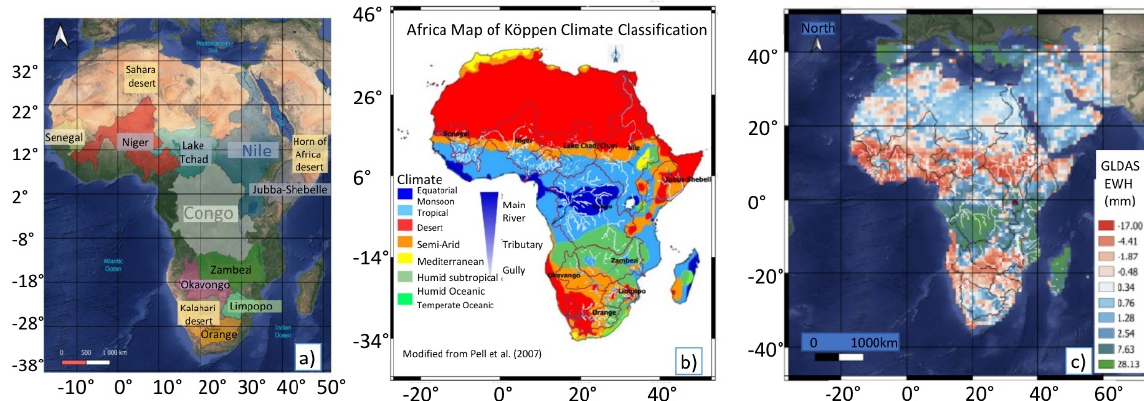
Figure 1. Hydrological and climate maps of Africa: ( a ) geographical masks of the main drainage basins. In this study, we analyzed two specific basins: Congo/Zaire (white color), and Nile (blue) but SF inversion have been made on the ten major basins, i.e., Niger (red, ~2.26), Zambezi (dark green, ~1.33), Orange (orange, ~0.97), Okavango (purple, ~0.72), lake Tchad-Chari (light blue, ~0.55), Jubba-Shebelle (grey, ~0.49), Limpopo (light green, ~0.41), and Senegal (yellow, ~0.3). Source: http://hydro.iis.u-tokyo.ac.jp/~taikan/TRIPDATA/TRIPDATA.html (last accessed on 31 March 2020); ( b ) map of climatic zones using the Köppen climate classification, the main watersheds are delimited by a dark red line and the associated hydrographic network corresponds to a dark blue line for the main rivers and a white line is used for small tributaries or gullies; ( c ) example of the January 2003 GLDAS simulation map, the variations of the EWH are expressed in mm.